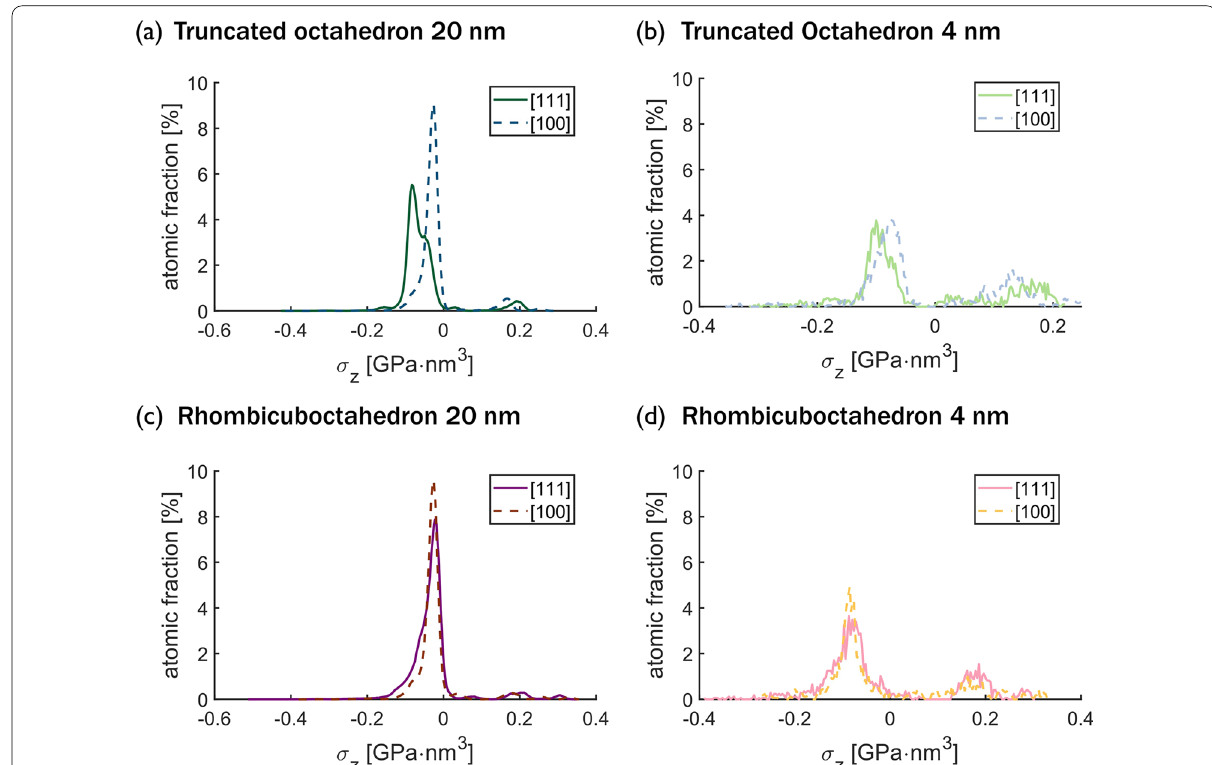
Fig. 4 Distributions of the virial stress per atom for 20 nm and 4 nm nanoparticles. Virial stress histograms for atoms in cross-sections of thickness 7 nm parallel to the load direction for a 20-nm truncated octahedron, b 4-nm truncated octahedron, c 20-nm rhombicuboctahedron, and d 4-nm